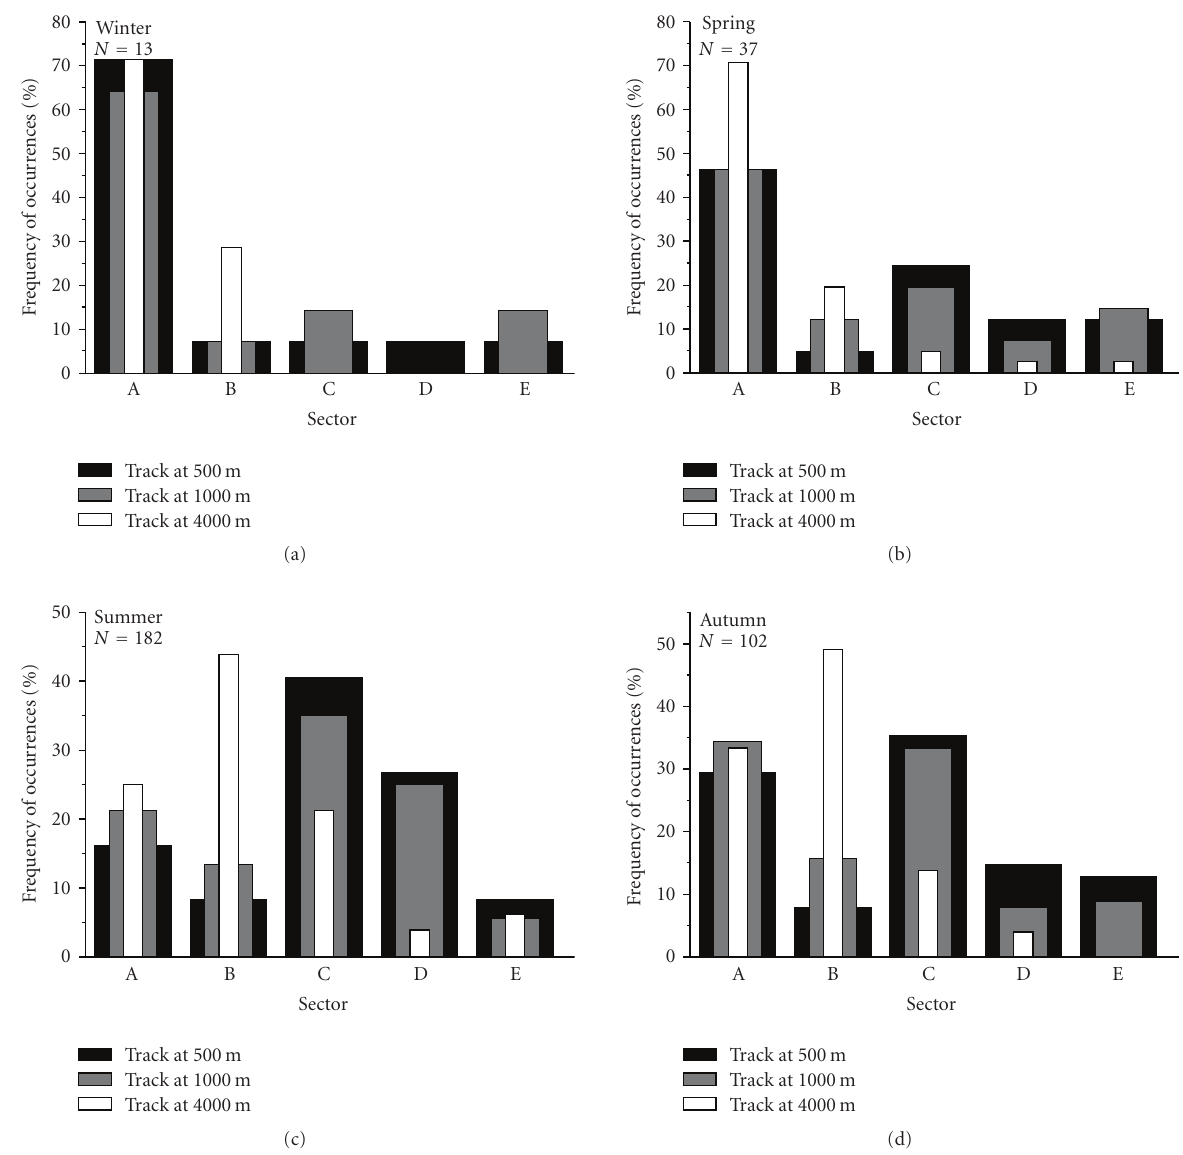
Figure 8: Same as in Figure 6, but for the DD aerosol